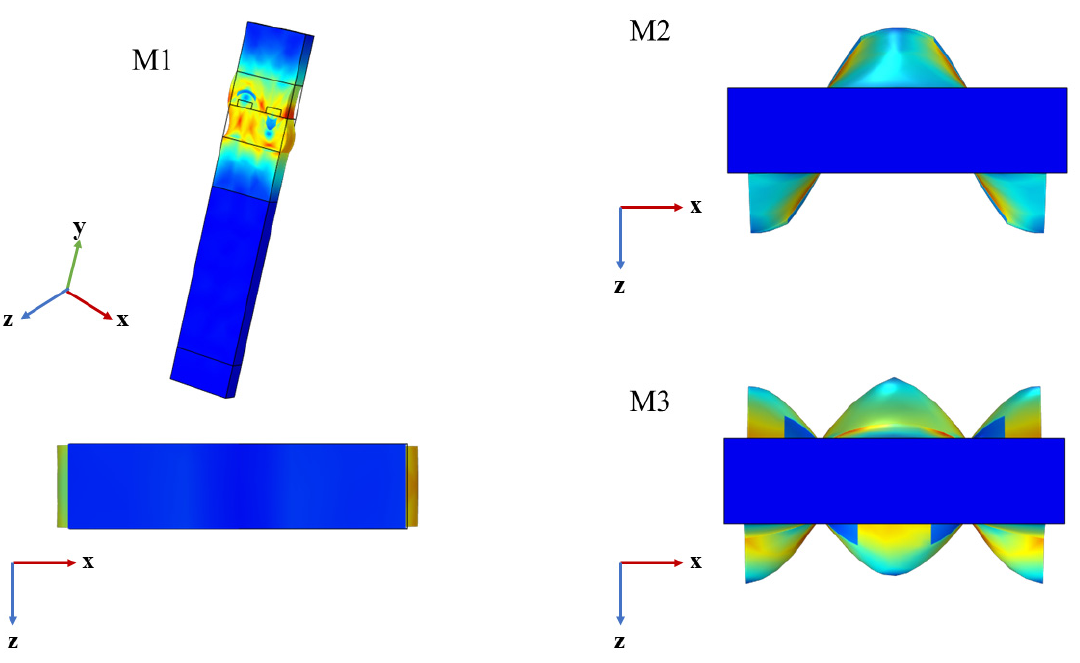
Figure 6. Vibration displacement diagram of three modes. (x is the SAW propagation direction, y is the vibration displacement direction of the Rayleigh wave particle, z is the vibration displacement direction of the love wave